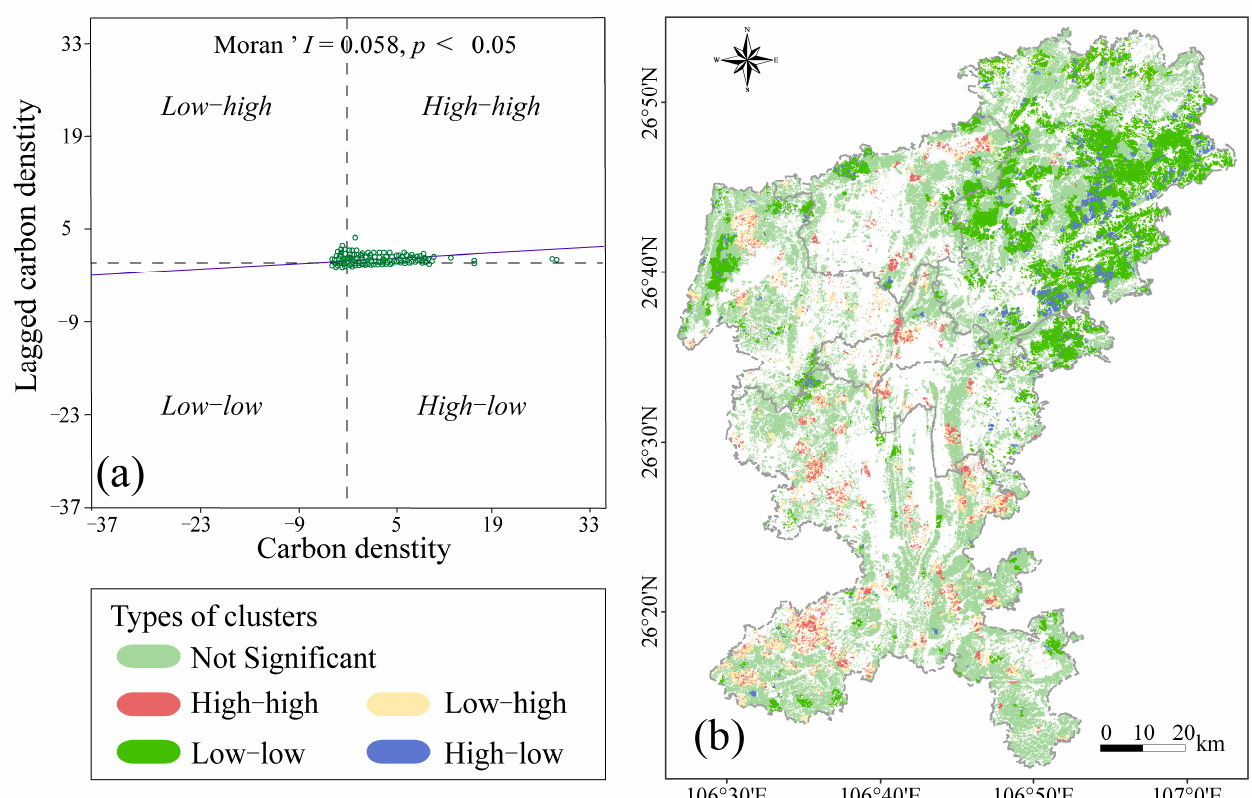
Figure 3. The Moran scatter diagram of carbon density ( a ); cluster map of carbon density detected by Anselin Local Moran’s I ( b ).